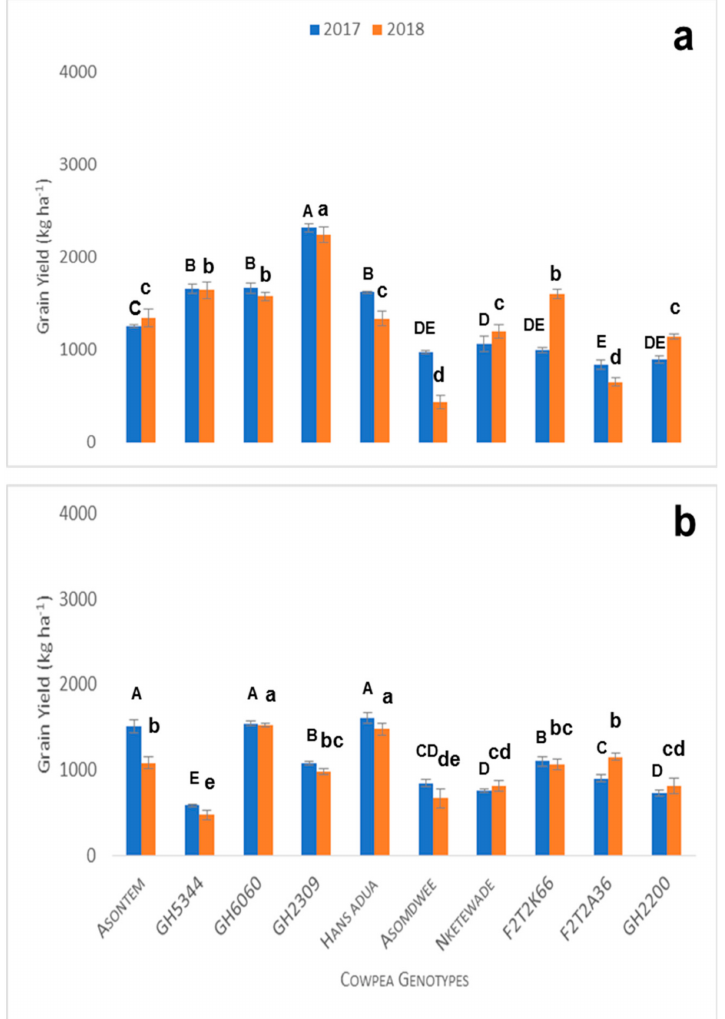
Figure 3. Grain yield of cowpea genotypes under water stress with phosphorus treatment (60P + WS) at maturity in 2017 and 2018 planting season ( a ) and grain yield under combined P and water stress conditions (0P + WS) at maturity in 2017 and 2018 ( b ). Vertical bars represent ± S.E. of the mean ( n = 3). Different letters above the columns indicate statistical significance at the p < 0.05 level within the same measurement stage (capital letters compare significance levels within 2017 and small letters compare significance levels within 2018). Bars showing the same letters indicate no significant differences between genotypes at p <